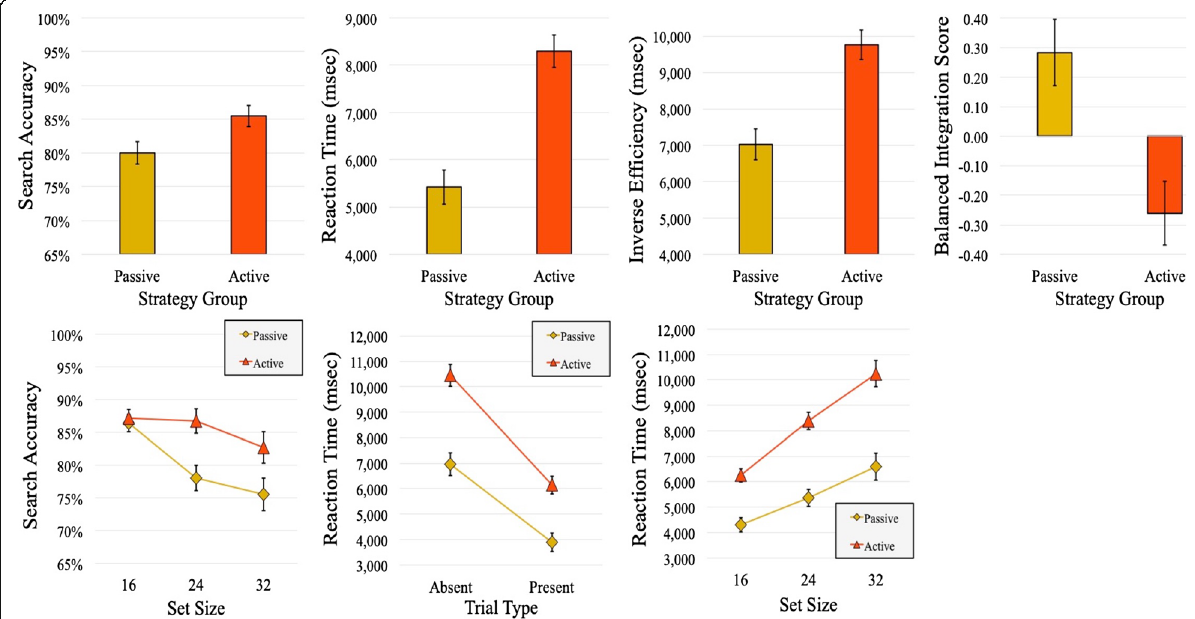
Fig. 4 Significant main effects and interactions with strategy, from experiment 2, behavioral measures. The top row presents all main effects, and the bottom row presents all two-way interactions. Error bars represent one standard error of the mean